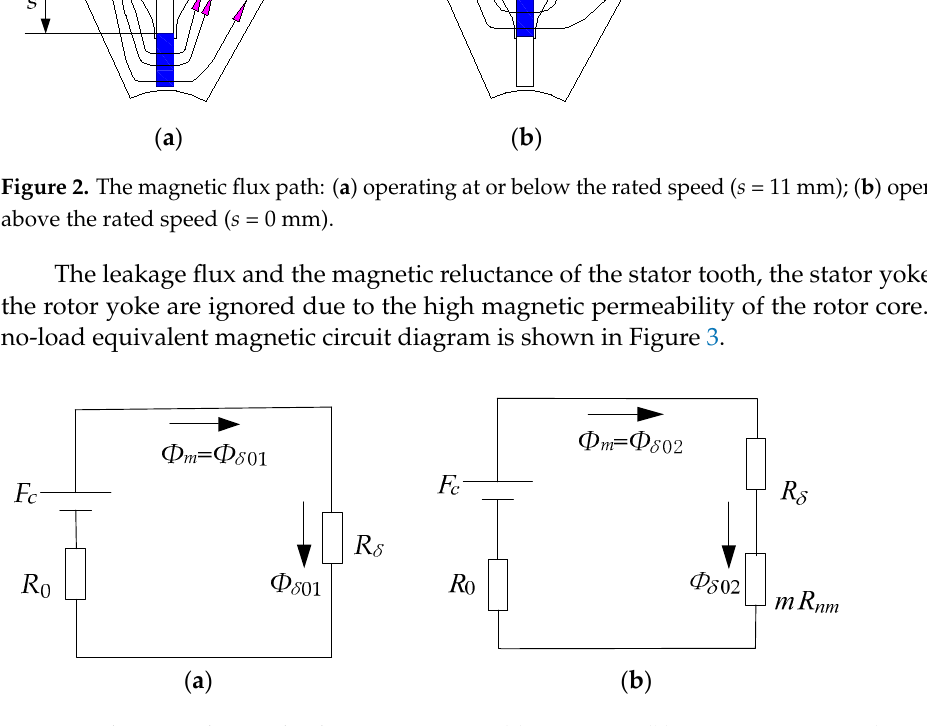
Figure 3. The equivalent no-load magnetic circuit: ( a ) s = 11 mm; ( b ) 0 mm ≤ s < 11 mm (0 < m ≤ 1). F c is the magnetic potential of the PM. Φ m is the magnetic flux provided by the PMs to the external magnetic circuit. Φ δ 01 and Φ δ 02 are the air-gap magnetic flux when s = 11 mm and 0 mm ≤ s < 11 mm, respectively. R 0 , R δ and R nm are the magnetic reluctances of the PM, the air gap and the whole NMC, respectively. m is a coefficient from 0 to 1.